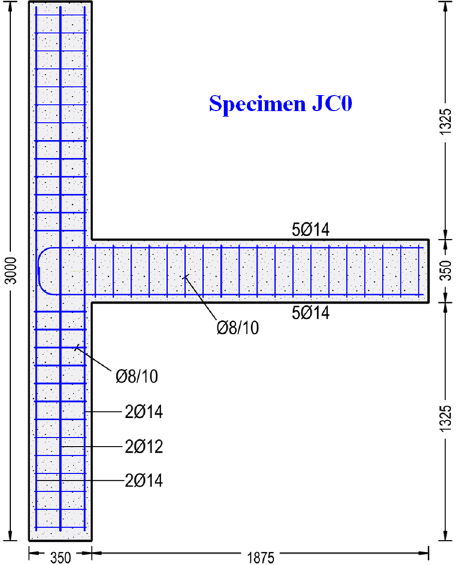
Figure 1. Specimen JC0. Geometrical and reinforcement characteristics.